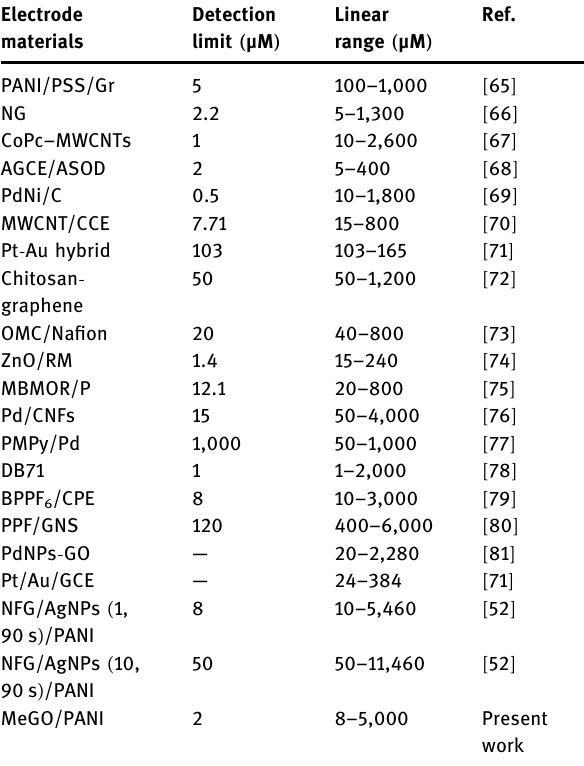
Table 1: The comparison of the linear range and detection limit of the present study with others Electrode